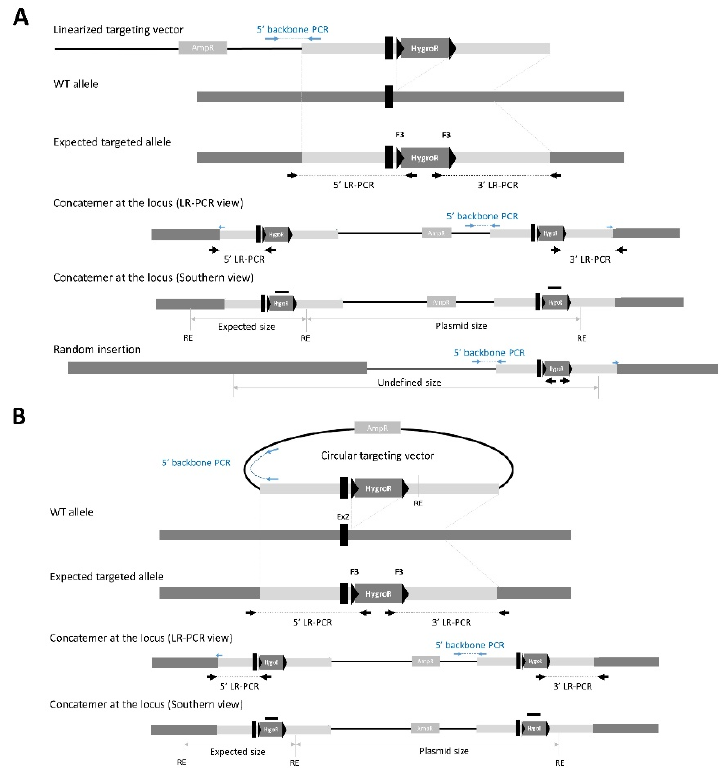
Figure 3. Scheme showing with the various alleles that are possible when a construct is electroporated in linear ( A ) or circular ( B ) form in the presence of a CRISPR/Cas9 construct. The position of the primers is shown. A scheme for a concatemer allele is shown here; both the LR-PCR view and Southern blot view (one restriction digest and one internal; Hygro probe, bold black line) are illustrated.